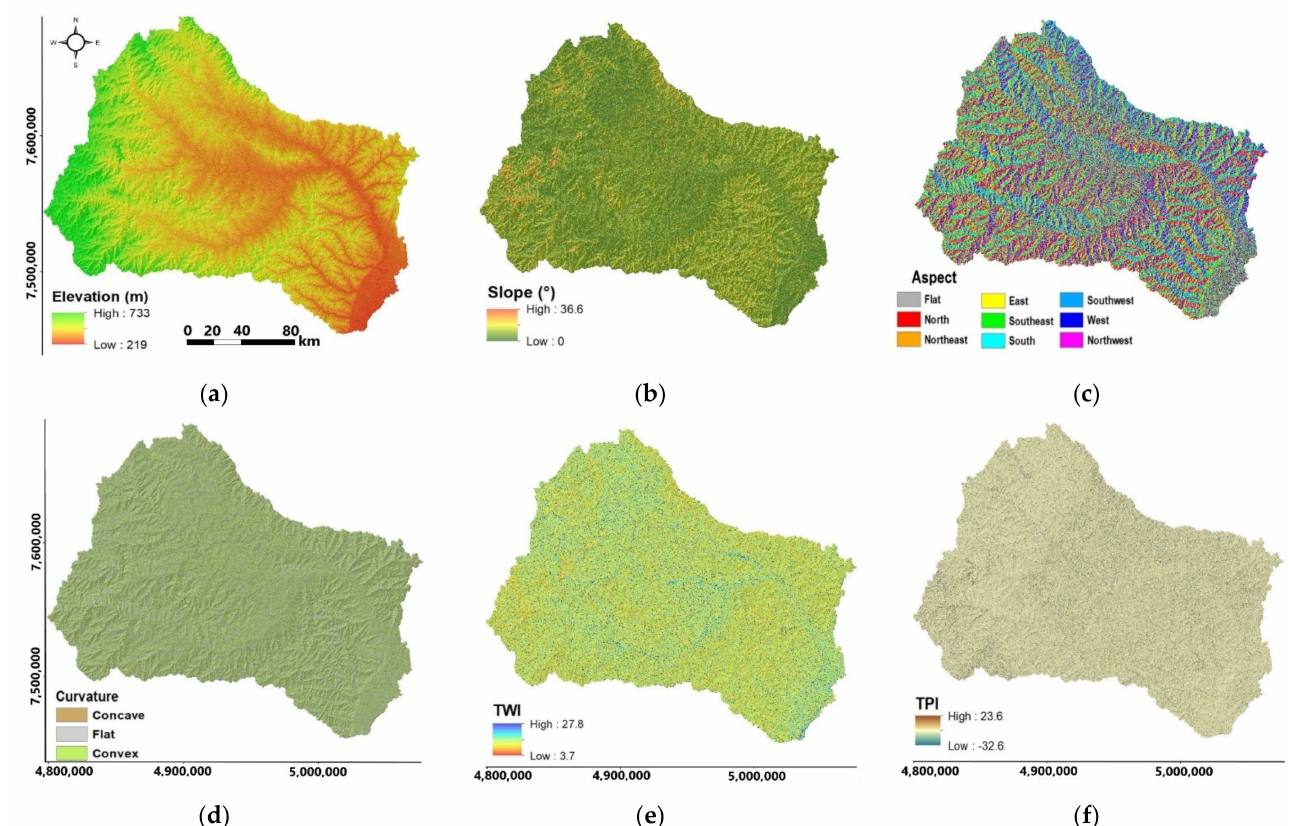
Figure 3. Selected input parameters: ( a ) elevation, ( b ) slope, ( c ) exposure, ( d ) landform curva- ture, ( e ) topographic wetness index and ( f ) topographic position index. Spatial references SIR- GAS_2000_Brazil_Polyconic in